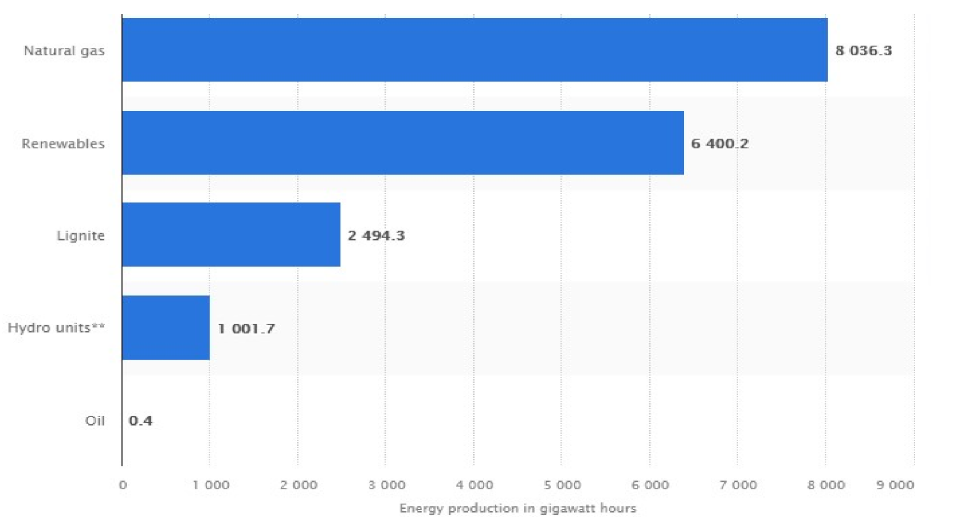
Figure 5. Sources of net energy production in Greece between January and June 2020 ** (in gi- gawatt hours).